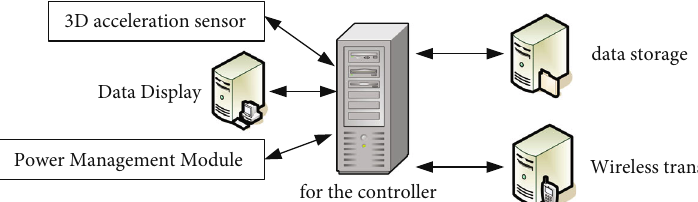
Figure 2: Composition of the data acquisition device.